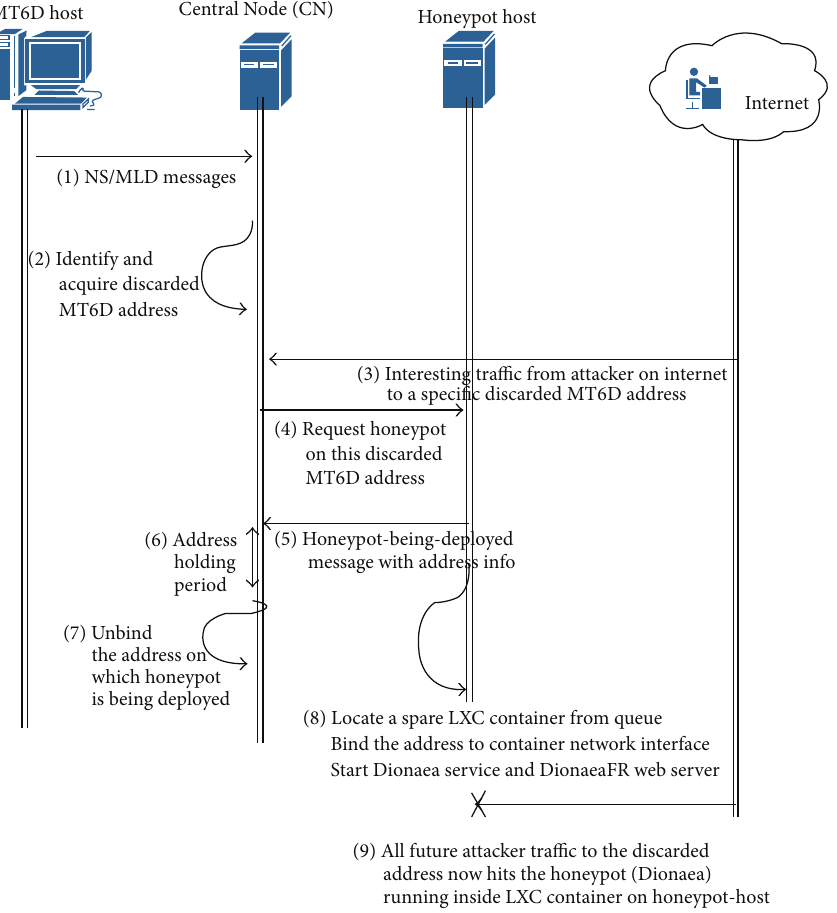
Figure 3: Flow diagram: sequence of messages exchanged between various